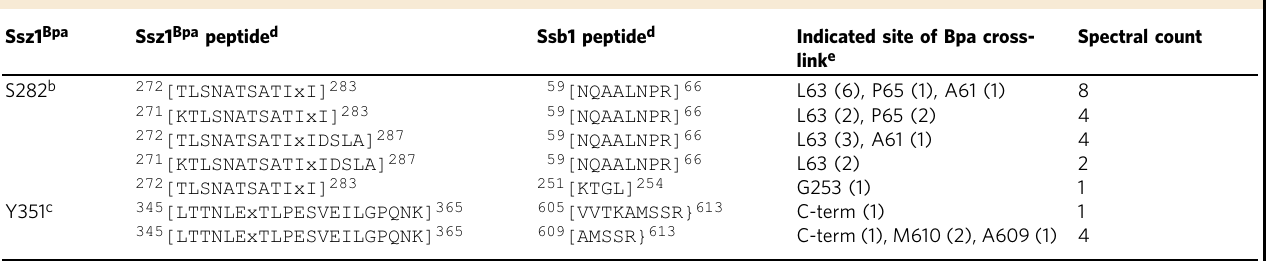
a StavroX analysis result depicting dipeptide crosslink products between Ssz1 S282Bpa or Ssz1 Y351Bpa and Ssb1. b Cross-linking products were digested with trypsin and AspN. c Cross-linking products were digested with trypsin. d The mass spectrometry data were analyzed using StavroX, with dipeptides listed in the order that they fi rst appear in the ranked StavroX output. Only crosslinked peptides with scores above the false discovery rate of 1% are shown for each experiment. Superscript numbers indicate endpoints of peptide. Brackets “ [] ” indicate peptide H-N-termini and OH-C-termini, respectively; “ } ” indicates OH-C- terminus of intact protein. Numbering re fl ects amino acid numbering of full-length protein; standard one letter designation used except: x = Bpa. e Number in brackets for indicated site of crosslink gives spectral count for that